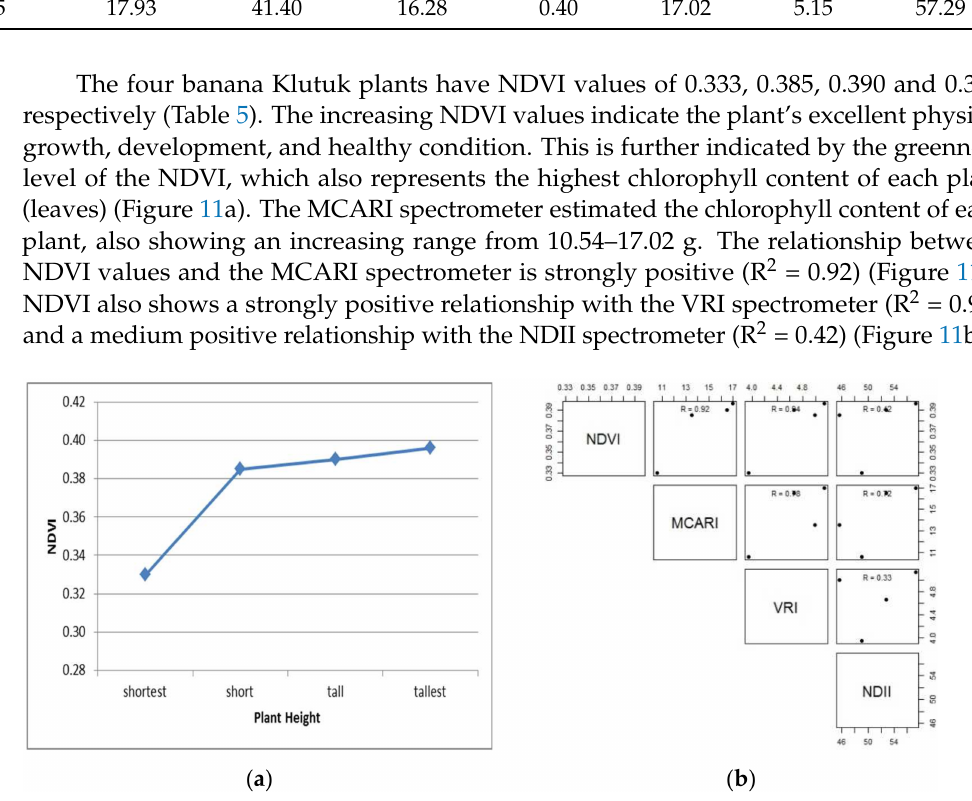
Figure 11. The relationship between NDVI trends and other indices of Klutuk, based on its size, from shortest to tallest.The relationship between NDVI values and the MCARI spectrometer is strongly positive (R2 = 0.92) (Figure 11a). NDVI also shows a strongly positive relationship with the VRI spectrometer (R2 = 0.94), and a medium positive relationship with the NDII spectrometer (R2 = 0.42) (Figure 11b). The MCARI spectrometer’s relationships with the VRI and NDII spectrometers also showed a strong relationship with R 2 values of 0.8 and 0.72, respectively. Only the rela- tionship between the VRI spectrometer and NDII spectrometer showed a weak positive relationship (R 2 values ~ 0.33). It is also worth noting that the increasing NDVI values correlate with increasing chlorophyll, nitrogen and water content of the Klutuk banana herbs. However, the amount of nitrogen needed does not always accompany an increase in water demand. It shows the low relationship between the VRI spectrometer and the NDII spectrometer (Figure